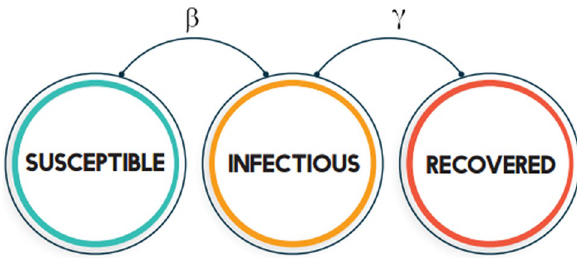
Figure 5. SIR state